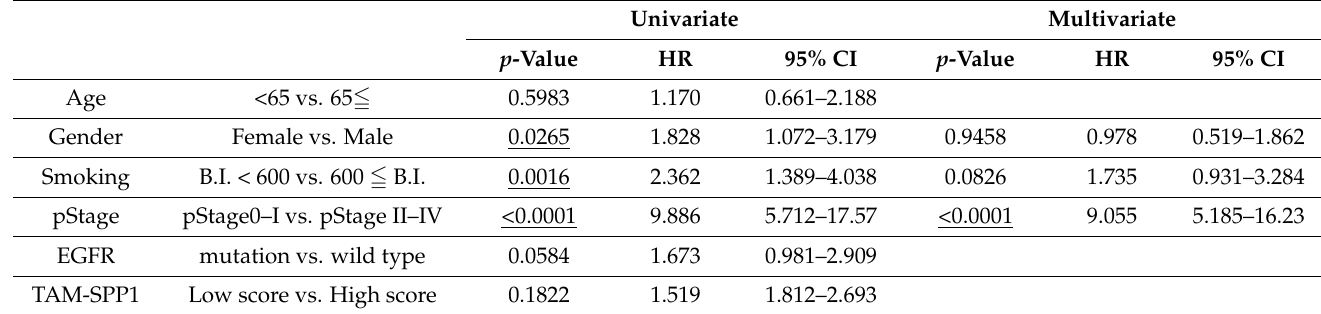
Table 5. Univariate and multivariate analyses for progression-free survival in lung adenocarcinoma.